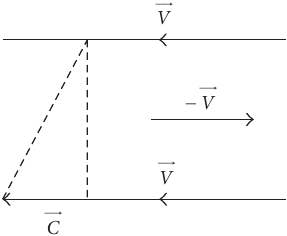
Figure 3: An overview of the relative motion between the two bod-